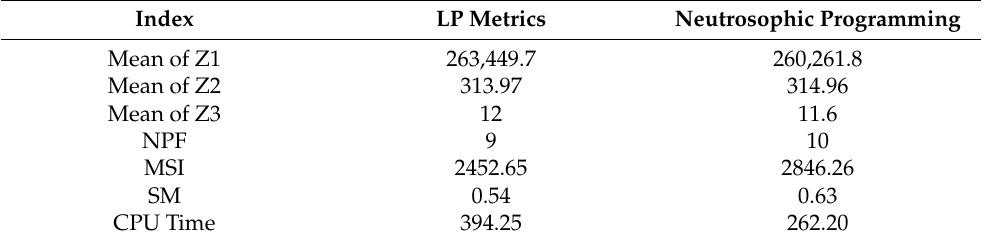
Table 10. Comparisons of efficient answers between different solution